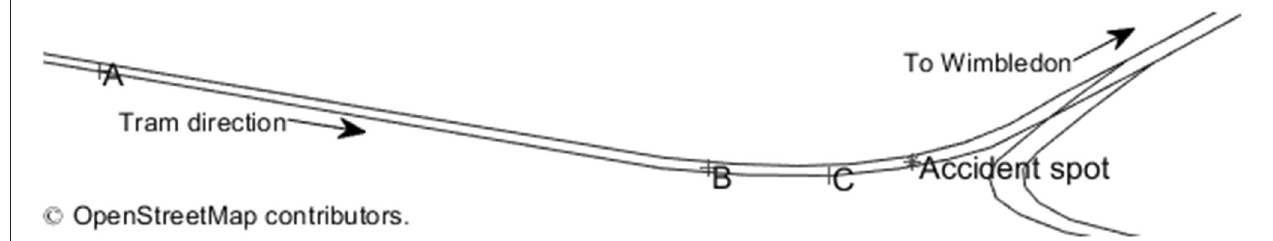
FIGURE 1 | Three points of interest to a maximum speed and braking distance analysis. The OpenStreetMap representation of the accident area is downloaded from